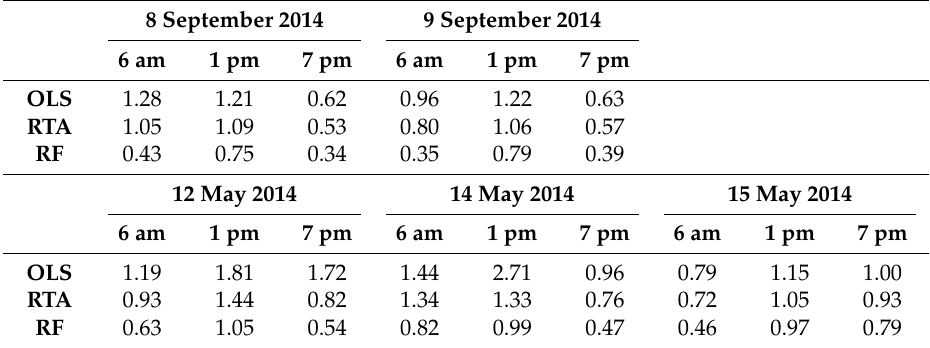
Table 4. Root Mean Square Error (RMSE) between predicted near-surface air temperatures and measured temperatures at the testing site (in Celsius).